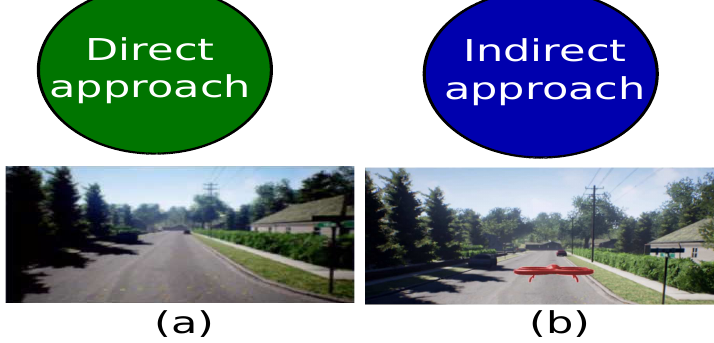
Figure 2. Path planning approaches. ( a ) Direct approach. ( b ) Indirect